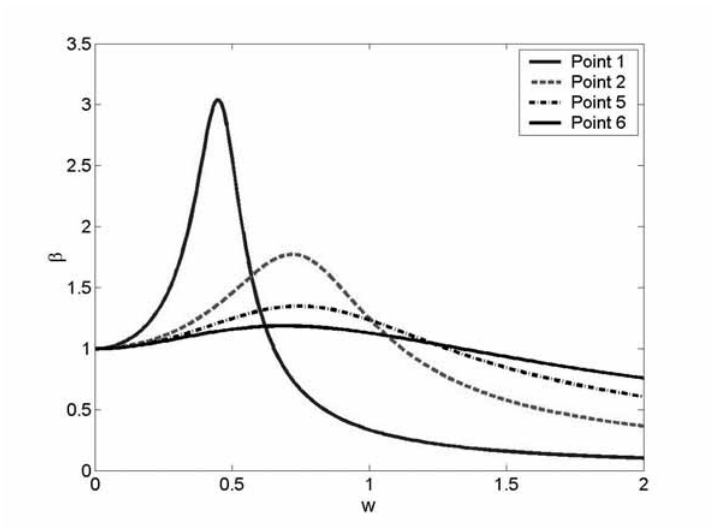
Fig. 29. Optimized absolute displacement frequency response.